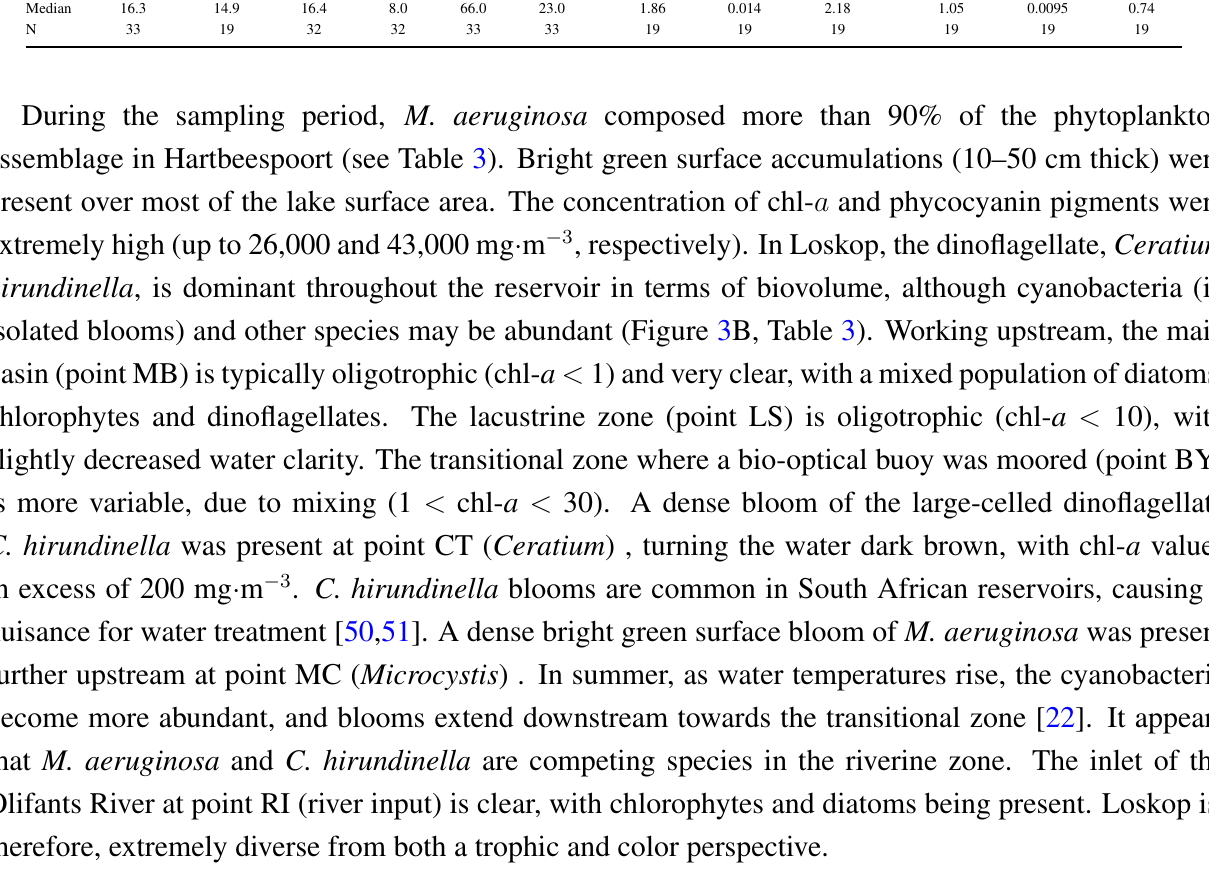
Table 1. Variability in biogeophysical and optical parameters for each reservoir. Chl- a , chlorophyll- a .